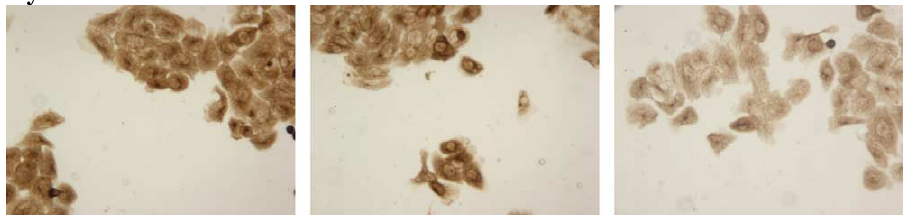
Fig. 4. Decreased E-cadherin, polarised Vimentin and decreased Cytokeratin 18 expression after TGF- β 1 treatment. Strong membranous E-cadherin immunoreactivity was observed after Mock treatment. Membranous E-cadherin immunoreactivity was retained in SdM treated cells, but was less intense when compared to Mock. After TGF- β 1 treatment, E-cadherin immunoreactivity was predominantly perinuclear and cy- toplasmic (arrows). Cell to cell contact was reduced. Homogenous staining of Vimentin was observed following treatment with either SdM or Mock. In contrast, Vimentin had a polarised distribution (arrows) and increased staining intensity following TGF- β 1 treatment. Further evidence of EMT changes were evident in the reduction of Cytokeratin 18 immunoreactivity in AY-27 cells following TGF- β 1 treatment the immunophe- notypes observed at 24 and 48 h were very similar. The images at 24 h are presented ( × 10 and × 40 objectives, Leitz Laborlux K, Germany). (The colors are visible in the online version of the